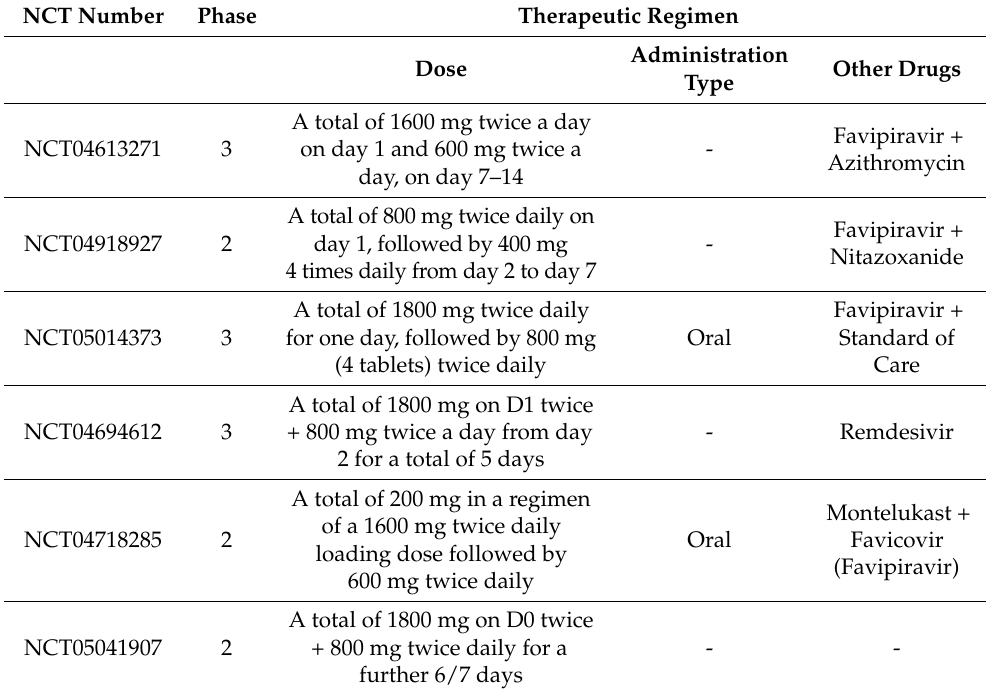
Table 3. Clinical trials using favipiravir for the treatment of COVID-19. Data was collected from clinicaltrials.gov on 28 November 2022. Inclusion criteria: Recruiting, adult population, from 1 Jan- uary 2022 to 31